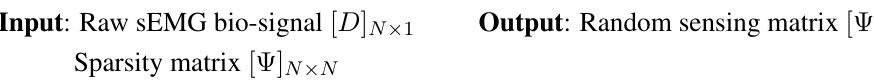
Table 3. Algorithm II: sensing matrix [Ψ]